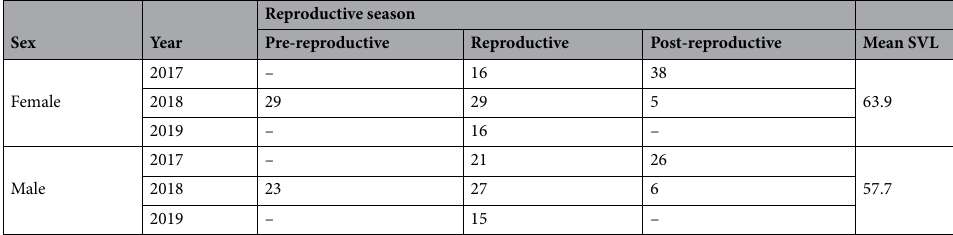
Table 1. Sampling of the cloacal microbiome of wild S. virgatus in three reproductive seasons, three years, and with regard to sex of sampled individuals. Values are sample sizes and mean snout-vent length (SVL) for the two sexes. In 2017 and 2018, sampling occurred every two weeks throughout the sampling period. In 2019, sampling occurred at only two time points (late May and late June). —indicates no sampling. Table excludes 6 females for which the reproductive state did not match the reproductive season (as defined in Statistical Analyses ); these 6 animals were only included in the reproductive state analysis,